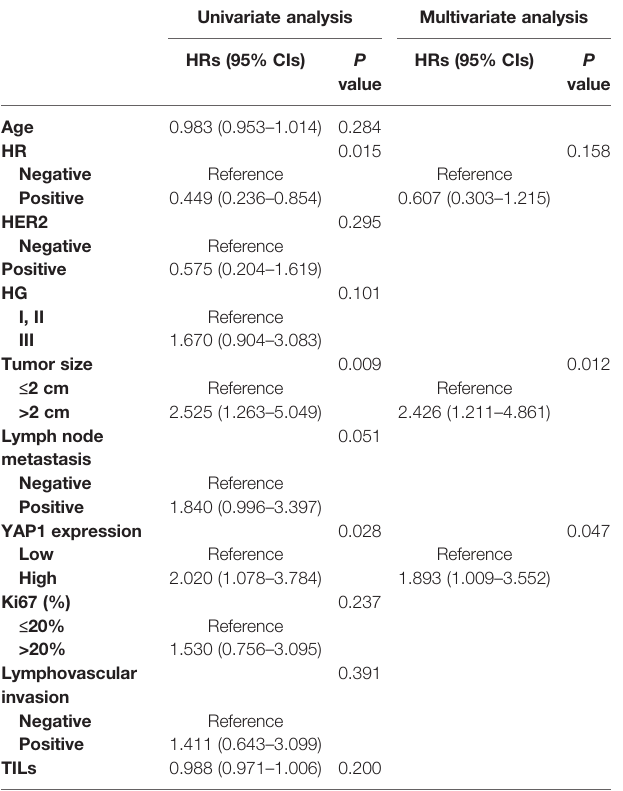
TABLE 2 | Hazard ratios (HRs) and 95% con fi dence intervals (CIs) for distant metastasis-free survival (DMFS). Univariate analysis Multivariate analysis